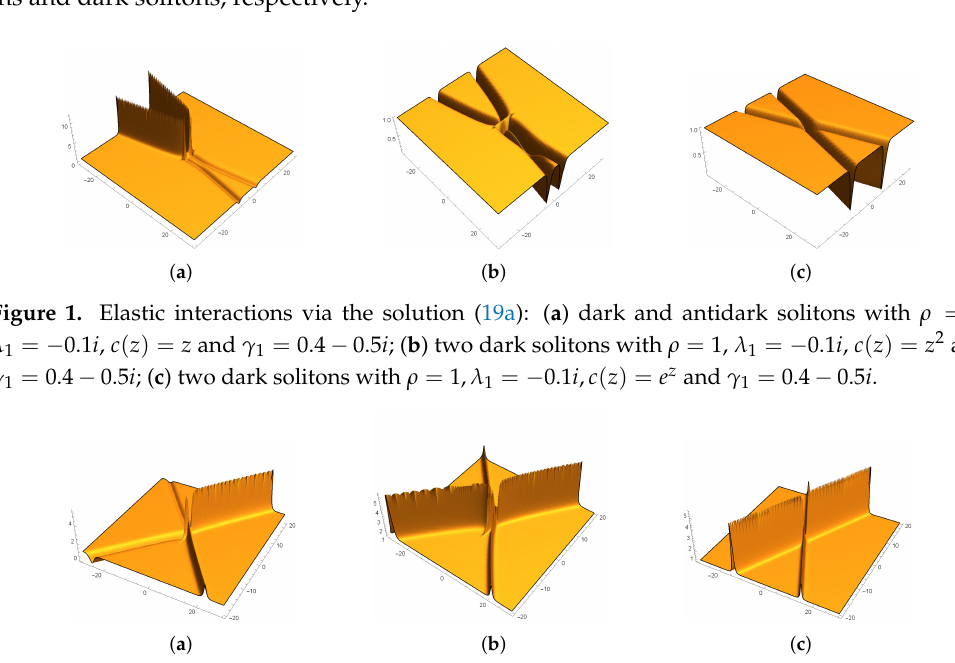
Figure 2. Elastic interactions via the solution (19a): ( a ) dark and antidark solitons with ρ = 1, λ 1 = 0.4 i , c ( z ) = z and γ 1 = − 2 − 0.6 i ; ( b ) two antidark solitons with ρ = 1, λ 1 = 0.4 i , c ( z ) = z 2 and γ 1 = − 2 − 0.6 i ; ( c ) two antidark solitons with ρ = 1, λ 1 = 0.4 i , c ( z ) = e z and γ 1 = − 2 − 0.6 i